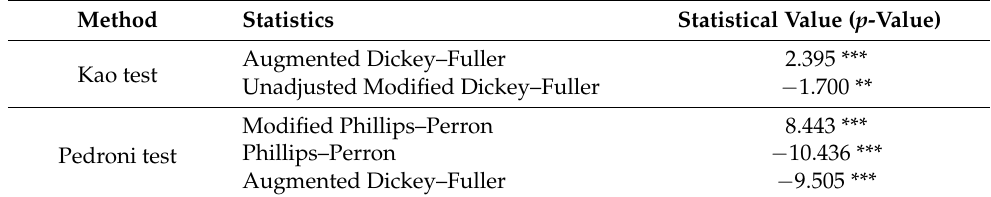
Table 4. Result of panel cointegration test.